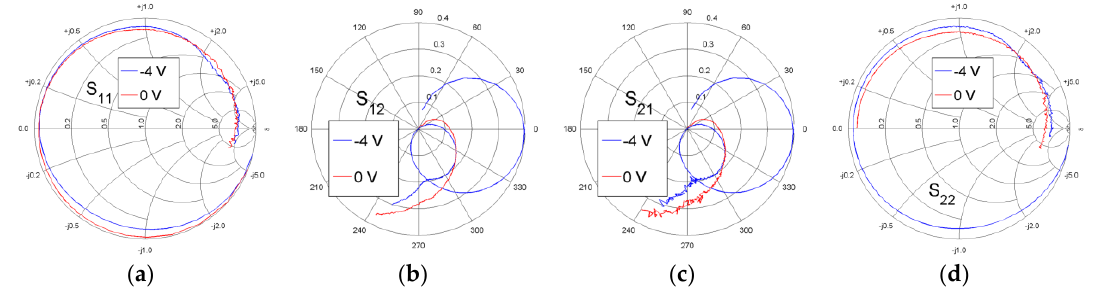
Figure 7. Measured ( a ) S 11 , ( b ) S 12 , ( c ) S 21 , and ( d ) S 22 from 0.2 to 65 GHz for a GaN HEMT at T a = 35 °C and V DS = 0 V for two values of V GS : −4 V and 0 V.